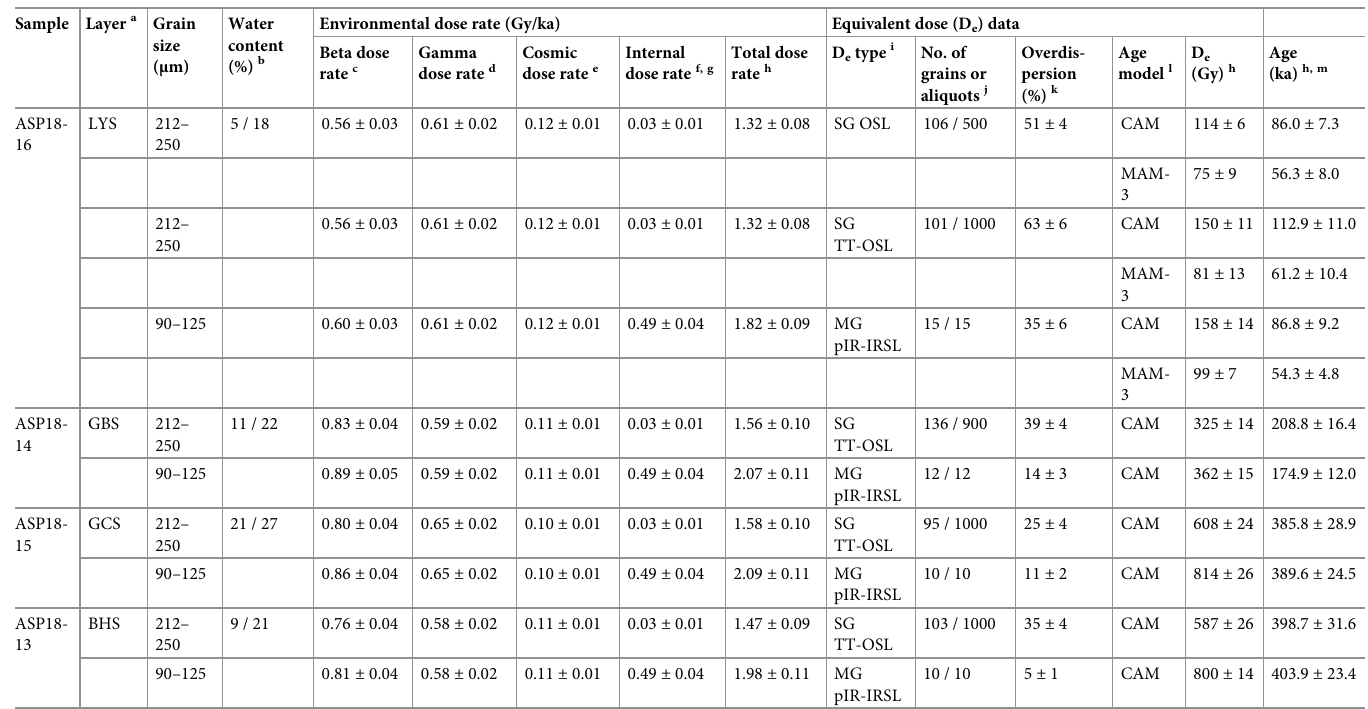
Table 1. Dose rate data, equivalent doses and luminescence ages. Sample Layer a Grain